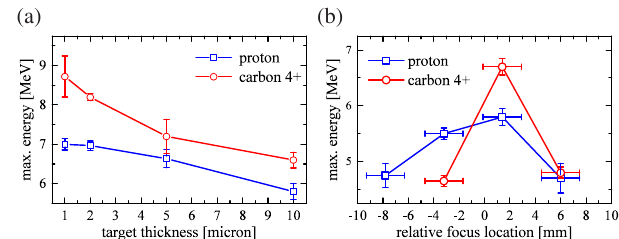
FIG. 1. Measured maximum ion energies for proton (blue) and carbon (C 4 þ ) ions (red) in MeV as a function of Ti-target thickness (a) and relative focus-target distance (b) adjusted with the deformable mirror for the 10 μ m target. The vertical error bars represent the standard deviation from shot-to-shot variation over five consecutive shots [(a) and (b)]. The horizontal error bars represent the accuracy of the focus positioning using the DM (b).